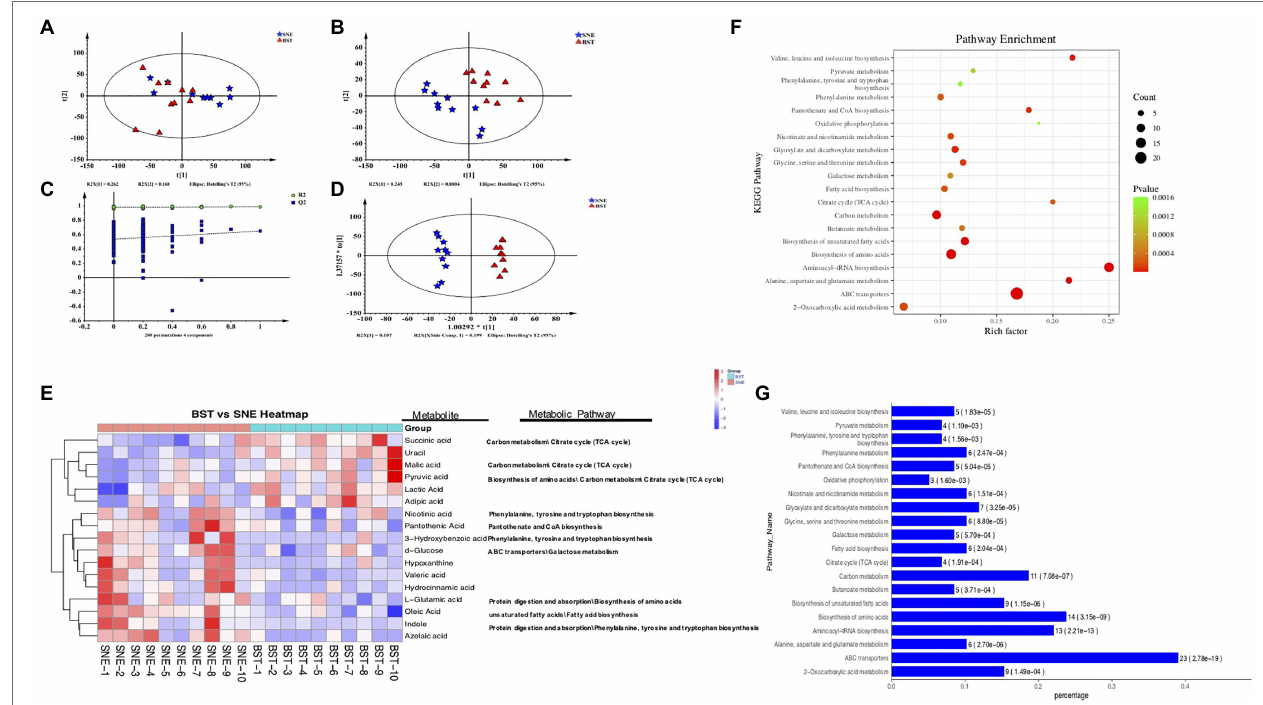
FIGURE 6 | (A) Principal component analysis (PCA) score plots (R2X = 0.534, Q2 = 0.252), (B) projections to latent structure-discriminant analysis (PLS-DA) score plots (R2X = 0.52, R2Y = 0.987, Q2 = 0.651), ( C) permutation test of PLS-DA, and (D) orthogonal projections to latent structure-discriminant analysis (OPLS-DA) score plots (R2X = 0.52, R2Y = 0.987, Q2 = 0.507). Blue pentagon: SNE; red triangle: BST, green circle: R2; blue square: Q2. The dashed line represents the regression line for R2 and Q2; (E) Heatmap of metabolites in cecal contents between BST vs. SNE groups. The relative values for each of these metabolites are indicated by color intensity with the legend indicated at the right of the figure. Red and blue represent higher and reduced concentrations of metabolites in the BST and SNE groups; (F) Bubble (up) and (G) bar (down) charts of top 20 most KEGG enrichment analysis of the differential metabolites between BST vs. SNE groups. “Rich factor” means that the ratio of the DEMs number and the number of metabolites have been annotated in this pathway. The greater of the Rich factor, the greater the degree of enrichment (bubble chart); along x -axis values represents enrichment ratio. The horizontal axis represents the number of count, the corresponding value of p in brackets, and the vertical axis is pathway name (bar charts). Ctr group, basal diet in control group; SNE group, basal diet + SNE (20-fold dose coccidiosis vaccine) +1 ml of Clostridium perfringens (2 × 10 8 cfu/ml coinfection); BST group, basal diet (days 1–21) + 1 × 10 9 colony-forming units (cfu)/kg BS diet (days 22–63) +